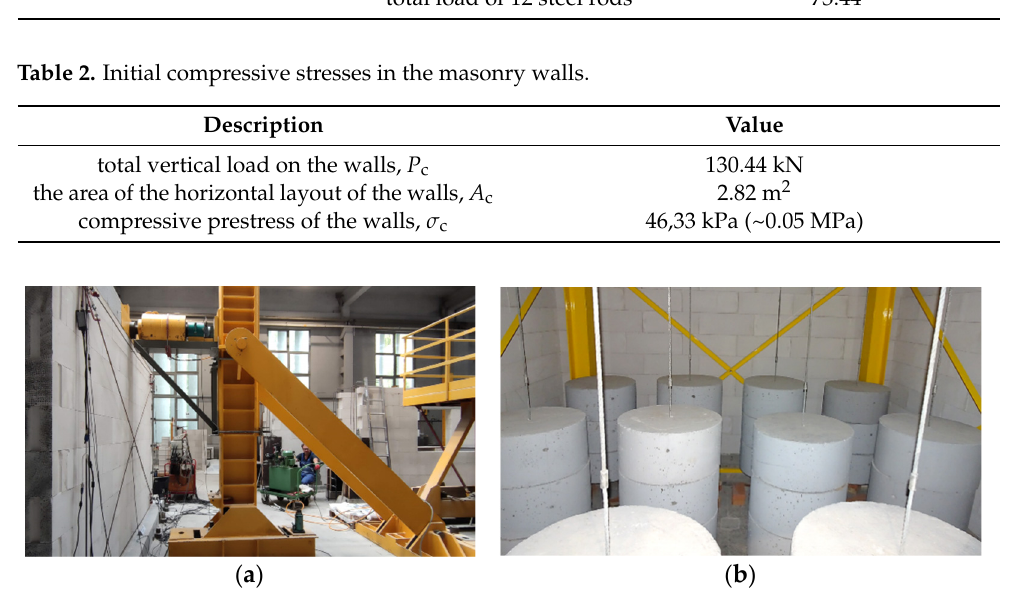
Figure 5. Loads of single-storey buildings; ( a ) horizontal load; ( b ) vertical load.